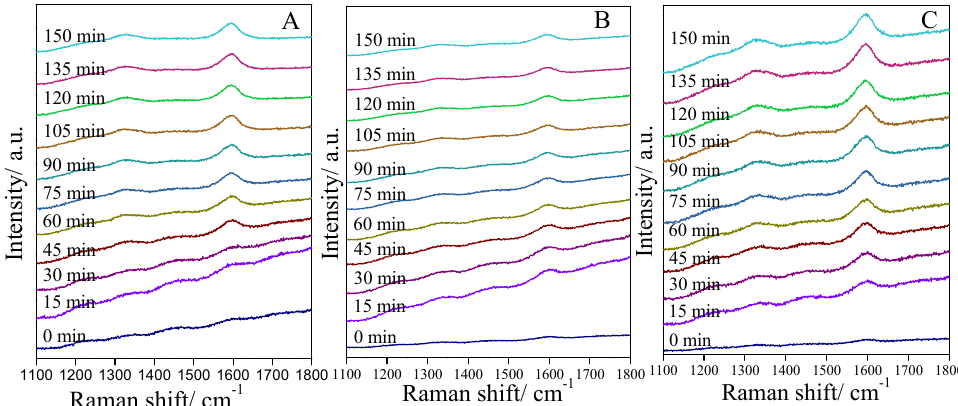
Figure 7. In situ Raman spectra of PtSn/Al 2 O 3 catalysts: ( A ) PtSn/Al 2 O 3 -2, ( B ) PtSn/Al 2 O 3 -9 and ( C ) PtSn/Al 2 O 3 -12.